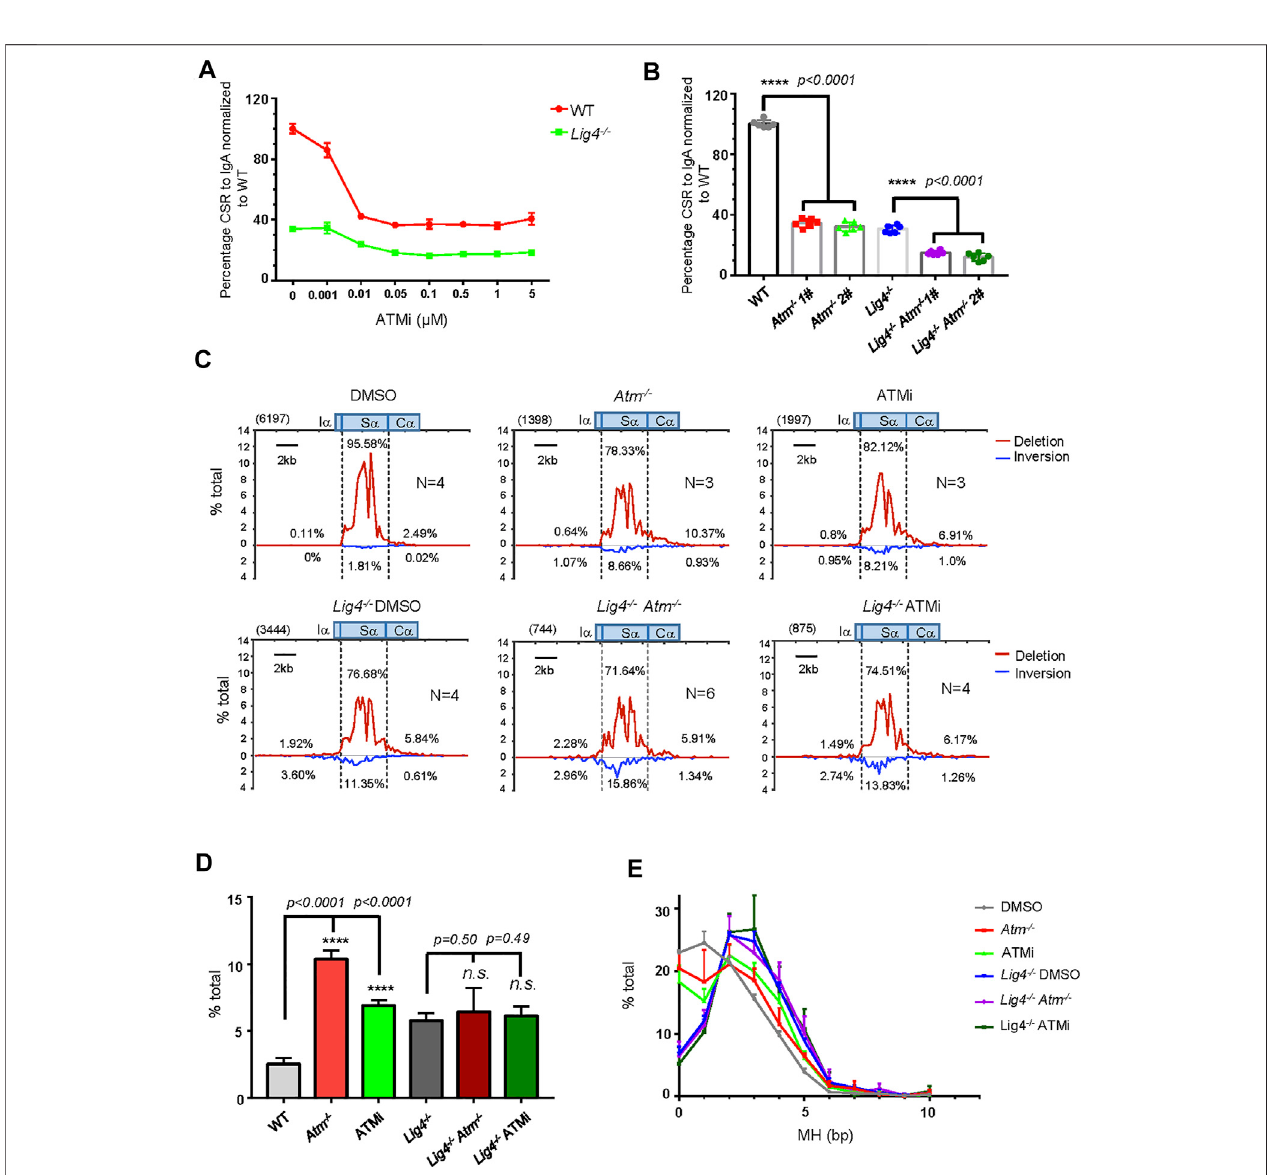
FIGURE 3 | domain deleted WT and Lig4 − / − cells. Data were presented as mean ± SD from six independent experiments (Student ’ s t -test, * p < 0.05, ** p < 0.01, *** p < 0.001, **** p < 0.0001, n. s. ( p > 0.05) indicates non-signi fi cant differences). (E) Linear distribution of pooled S μ -S α junctions recovered from HTGTS libraries with CSR activated Lig4 − / − Blm Δ HRDC cells. Numbers ( N ) indicated experiment repeats. (F) Percentage of long resection junctions in Lig4 − / − Blm Δ HRDC cells. Data were presented as mean ± SEM (Student ’ s t -test, * p < 0.05, n. s. ( p > 0.05) indicates non-signi fi cant differences). (G) The MH pattern of S μ -S α junctions in Lig4 − / − Blm Δ HRDC cells. Data were presented as mean ± SEM.